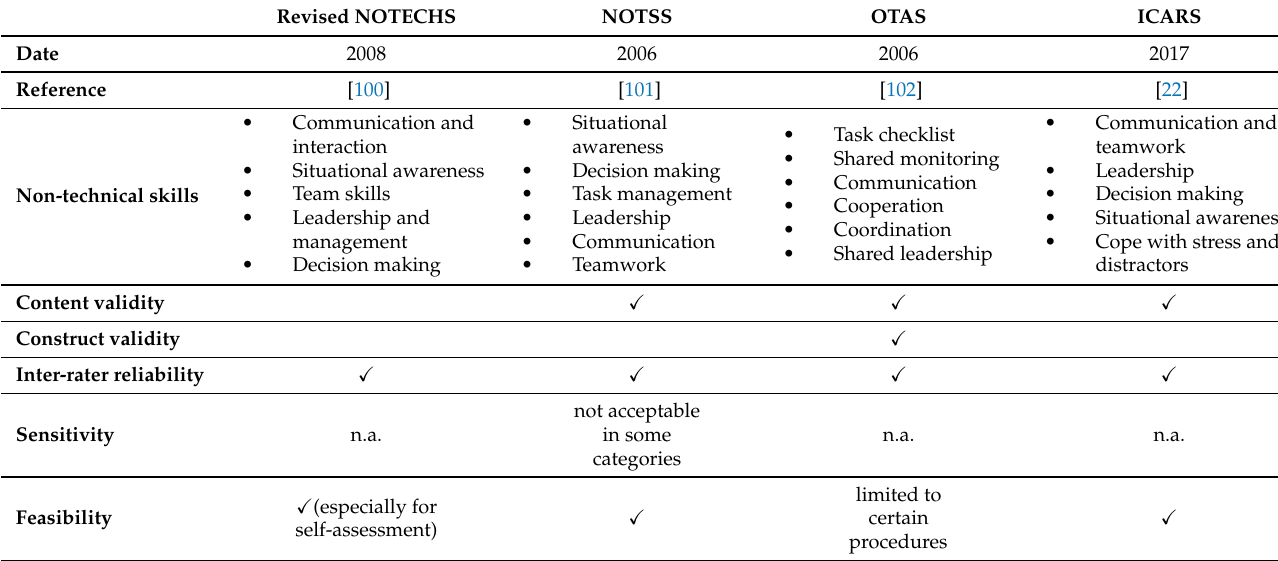
Table 3. Behavioral rating systems in traditional surgery compared to ICARS, the only established non-technical skill assessment metric particularly for RAMIS [21,22].